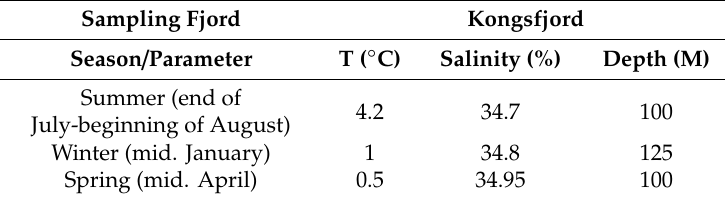
Table 1. Hydrological characteristics of the sampling sites of L. maculatus postlarvae in